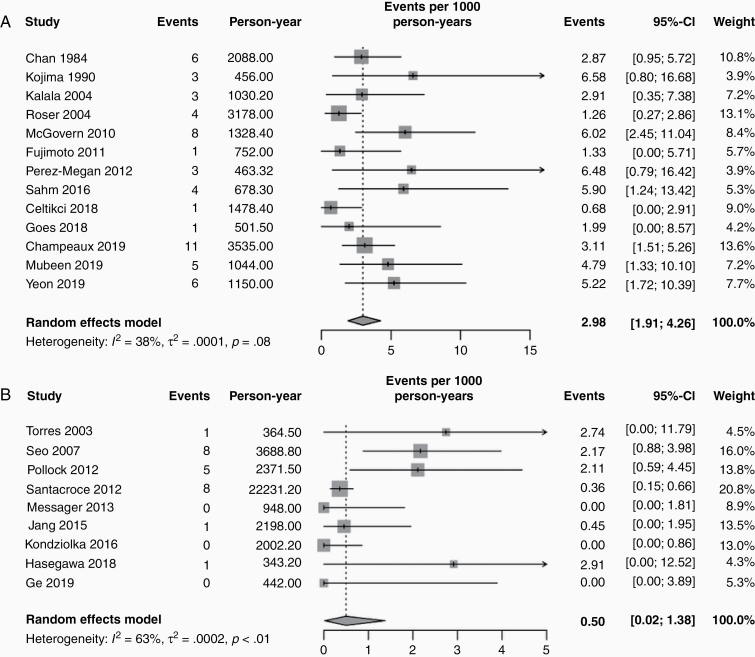
Forest plot showing the incidence rates of malignant transformation in the surgical (A) and radiosurgical series (B).